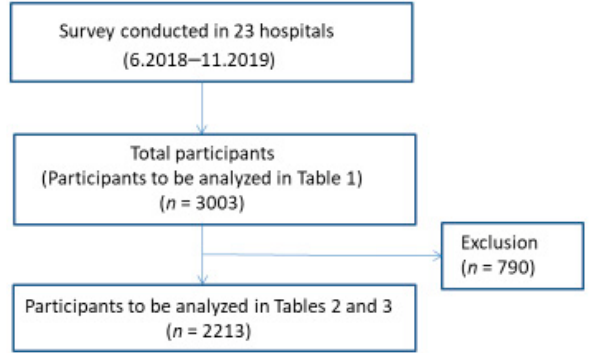
Figure 2. Flowchart of selection of study participants. Of the 3003 participants who completed the questionnaire survey, 790 did not answer questions regarding vaccination, educational level, annual household income, and so on or responded with “I do not know or want to answer.” After excluding these participants, 2213 participants were analyzed as shown in Tables 2 and 3. Table 3. Factors predicting rubella antibody titer among pregnant women ( N = 2213). Table 2. Factors predicting rubella vaccination among pregnant women ( N = 2213). Rubella Antibody